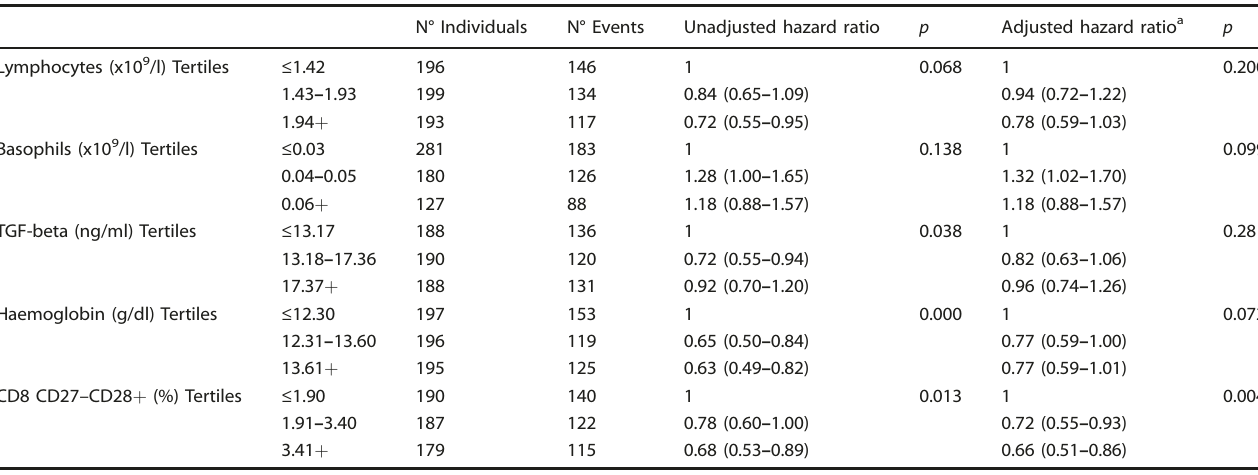
Table 2. All cause mortality Cox-regression model: CD8 CD27 – CD28 + .